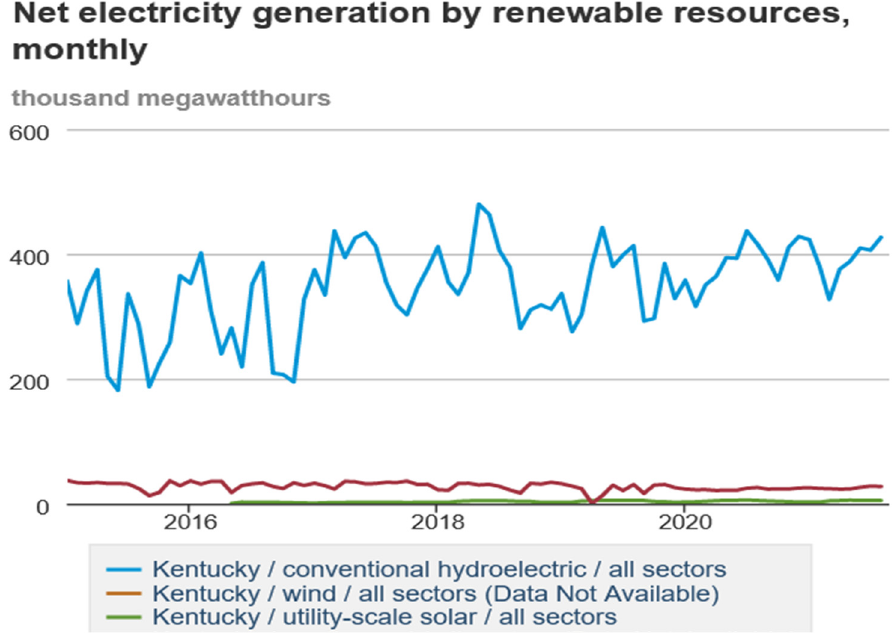
Figure 3. Net electricity generation by renewable resources monthly in Kentucky [8].